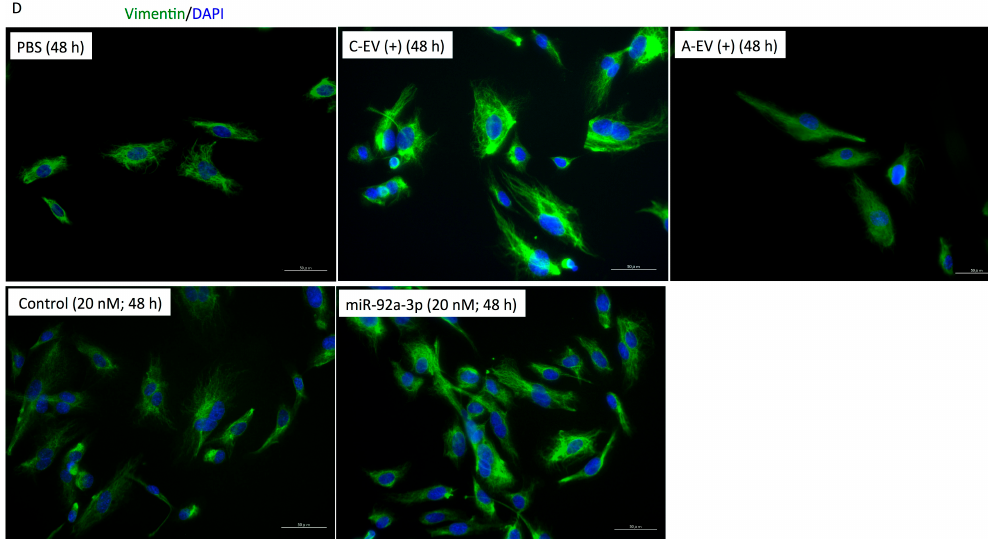
Figure 5. MiR-92a-3p induces “partial” Endothelial-to-Mesenchymal Transition (EndoMT; a hypothesis). ( A ) Functional interaction network constructed from miR-92-3p target genes ( CLDN11, Dkk-3, CD69, and ITGA5 ) using the GeneMANIA algorithm (https://genemania.org/): Network weighting is based on biological processes. Genes are arranged clockwise from high to low in terms of rank. A higher rank denotes that a gene is likelier to be related to the miR-92a-3p target genes arranged in the center. Networks are connected by physical interactions (73.97%), co-expression (14.65%), co-localization (6.61%), and pathway (4.76%). ( B ) Intracellular and extracellular levels of miR-92a-3p after the transfection of DLD-1 cells with nonspecific control miRNA or antagomiR-92a-3p at 20 nM. (C-EV, EVs isolated from nonspecific control miRNA-transfected DLD-1 cells; A-EV, EVs isolated from antagomiR-92a-3p-transfected DLD-1 cells. EVs were isolated at 96 h after the transfection). ( C ) Protein expression profiles of HUVECs incubated with EVs or transfected with miR-92a-3p. (C-EV(+), HUVECs incubated with C-EV for 48 h; A-EV(+), HUVECs incubated with A-EV for 48 h). Vimentin is a mesenchymal marker whereas ZO-1 is an epithelial marker. N.S., not significant; * p < 0.05, ** p < 0.01, and *** p < 0.001. ( D ) HUVECs immunostained at 48 h after incubation with EVs or transfection: Vimentin (green), nuclei of the HUVECs (blue). Scale bars: 50 µ m. EndoMT, endothelial-mesenchymal transition; miRNA, microRNA; HUVEC, human umbilical vein endothelial